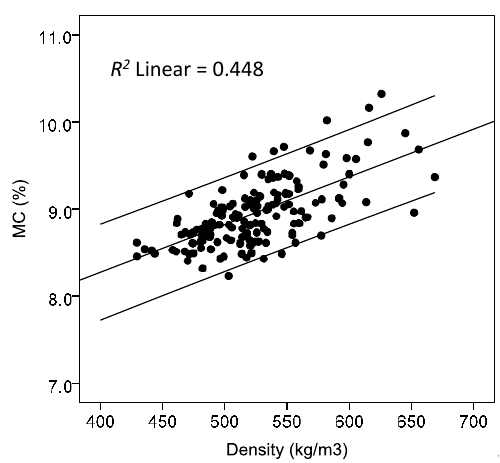
Figure 3. The correlation between MC and basic